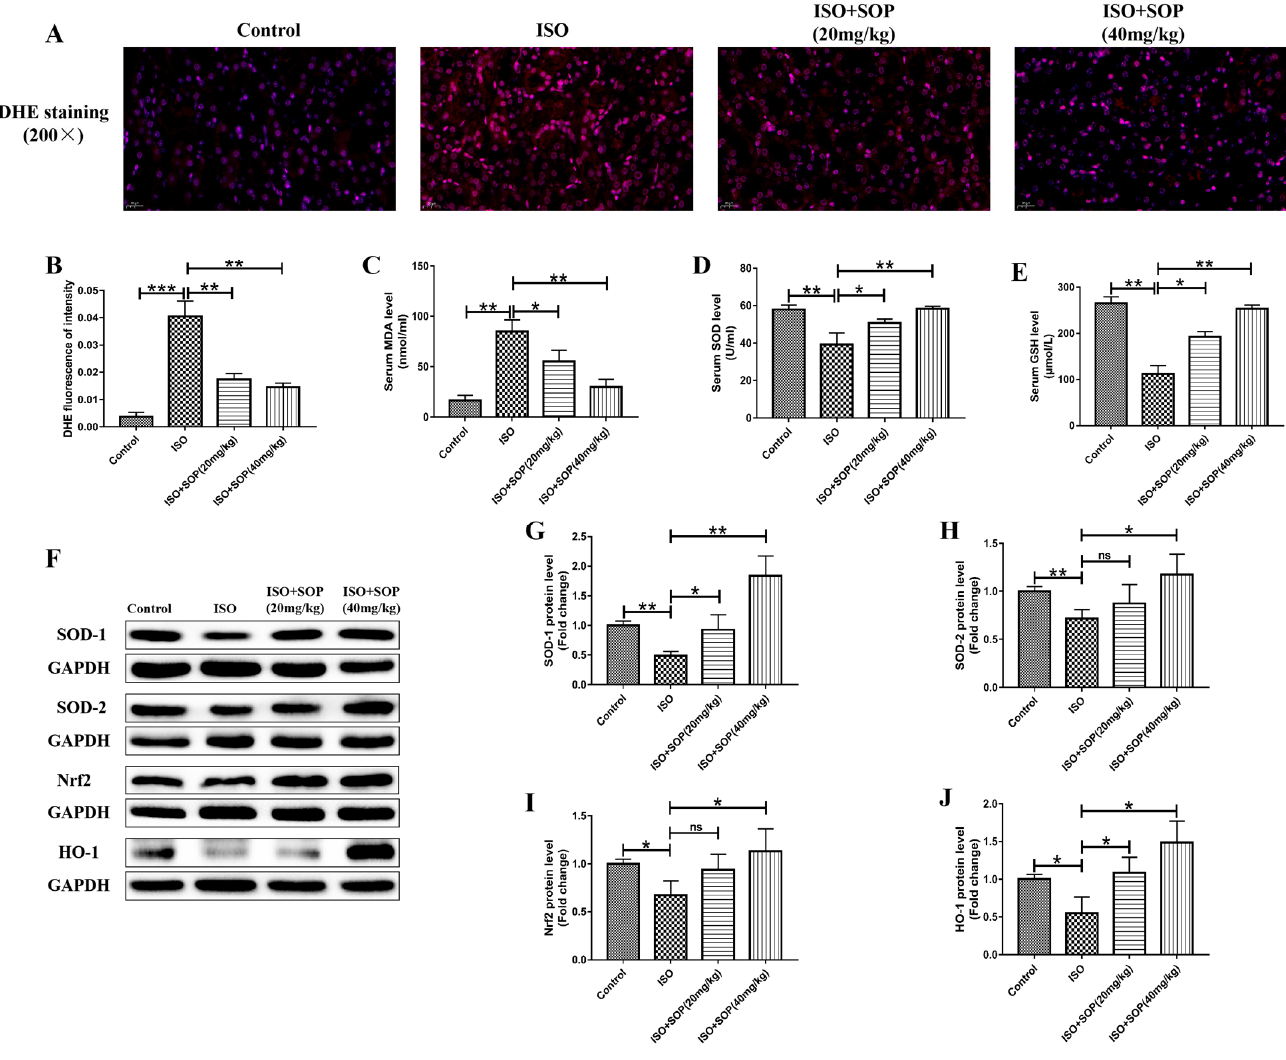
Figure 4. ( A , B ) A DHE staining assay was conducted to evaluate pathological changes in kidney tissues (n = 7–8). ( C – E ) Certain kits were applied to detect the serum levels of MDA, SOD and GSH (n = 7–8). ( F – H ) The protein expression levels of antioxidant proteins such as SOD-1 and SOD-2 were detected using a Western blotting assay (n = 7–8). ( F , I , J ) The protein expression levels of Nrf2 and HO-1 were also detected using a Western blotting assay (n = 7–8). ns means no statistical signifi-